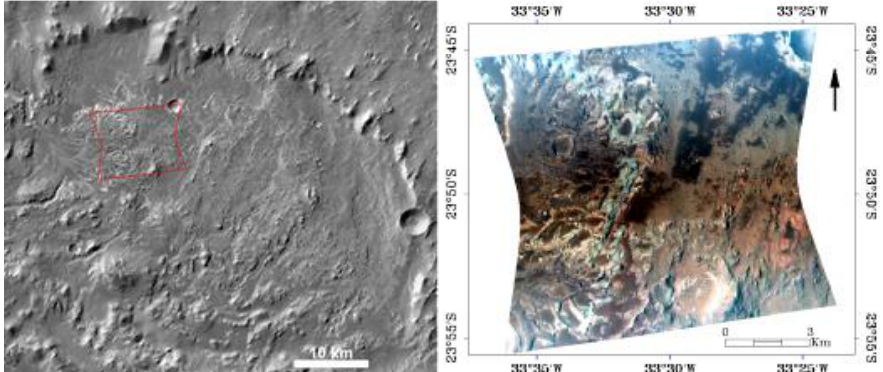
Figure 1. Eberswalde Crater.(a) Overview of Eberswalde Crater, which is a partially buried impact crater. Image is a mosaic of CTX images, overlain on the THEMIS 100 m/pixel global daytime infrared mosaic. CRISM FRT000060DD footprint is shown outlined in red. (b) CRISM image FRT000060DD (R:2.529μm, G:1.506μm, B: 1.080μm). North is up in both